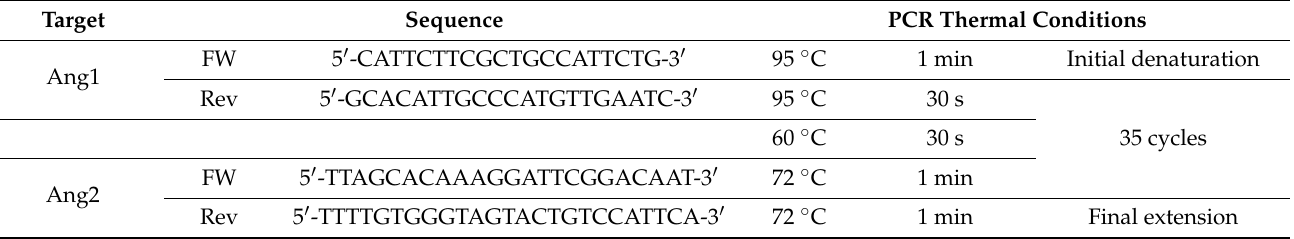
Table 2. The primers and thermal conditions of qPCR